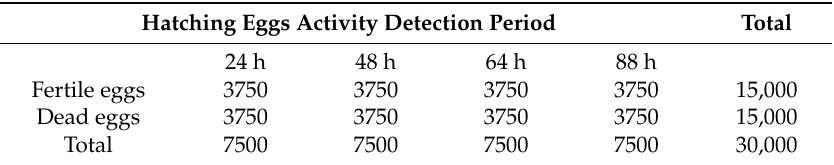
Table 1. Experimental dataset sample